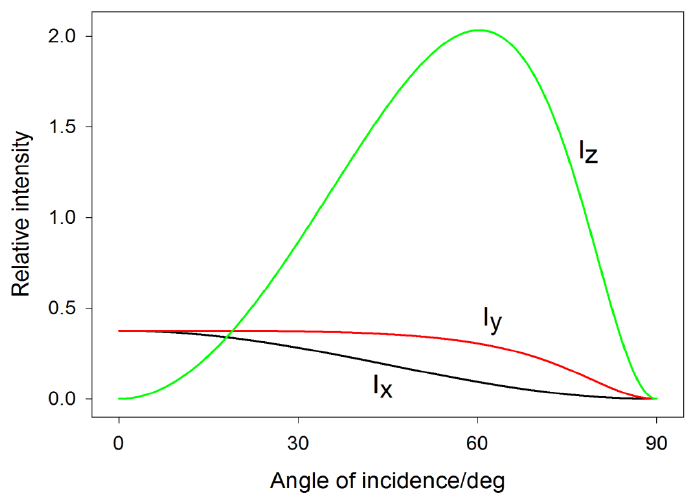
Figure 5. Calculated near-field intensities in the vicinity of a smooth Ag surface for an arbitrarily polarized light wave, 𝜆 = 500 nm. Calculations were performed for different angles of incidence and the refractive index 𝑛̃ 𝐴𝑔 = 0.05 + 3.09i [38].